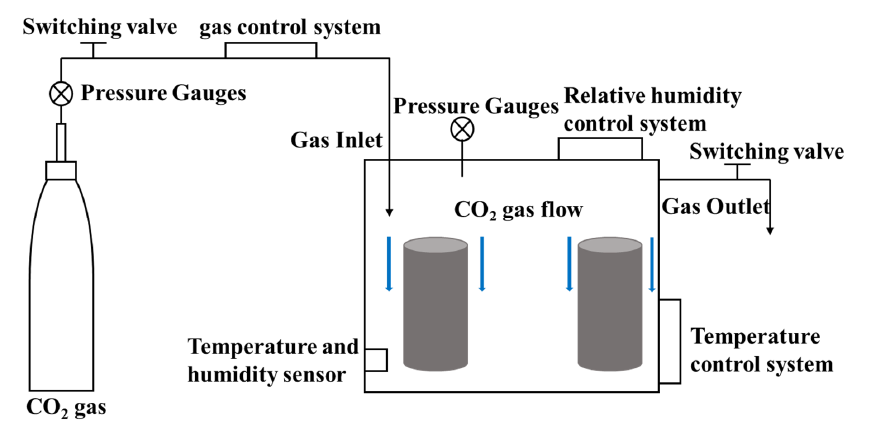
Figure 1. CO 2 curing device.